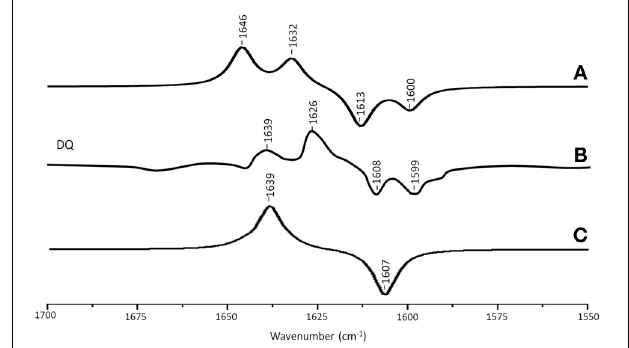
FIGURE 4 | (A) ONIOM calculated 18 O isotope edited DDS for neutral DQ in the Q A binding site. Experimental spectra are shown in (B) , and were taken from Breton et al. (1994a) with permission. (C) DFT calculated 18 O isotope edited DDS for neutral DQ. ONIOM and gas phase calculated spectra were scaled by 0.9718 and 0.9608, respectively.